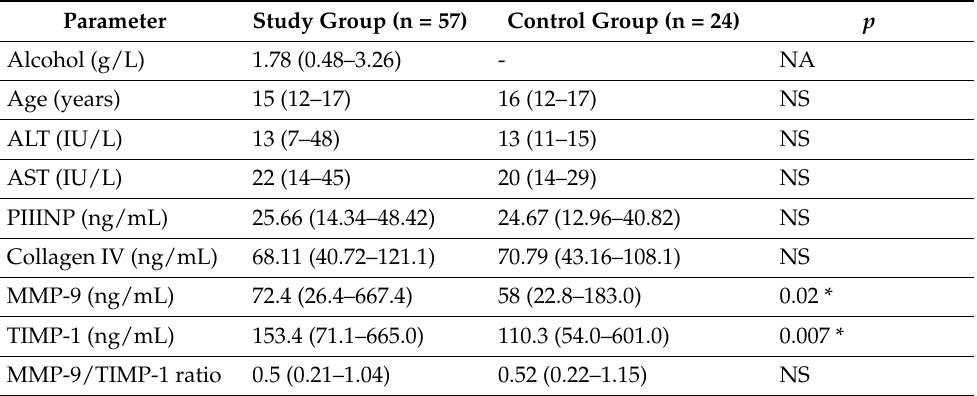
Table 1. Characteristics of the study and control groups.